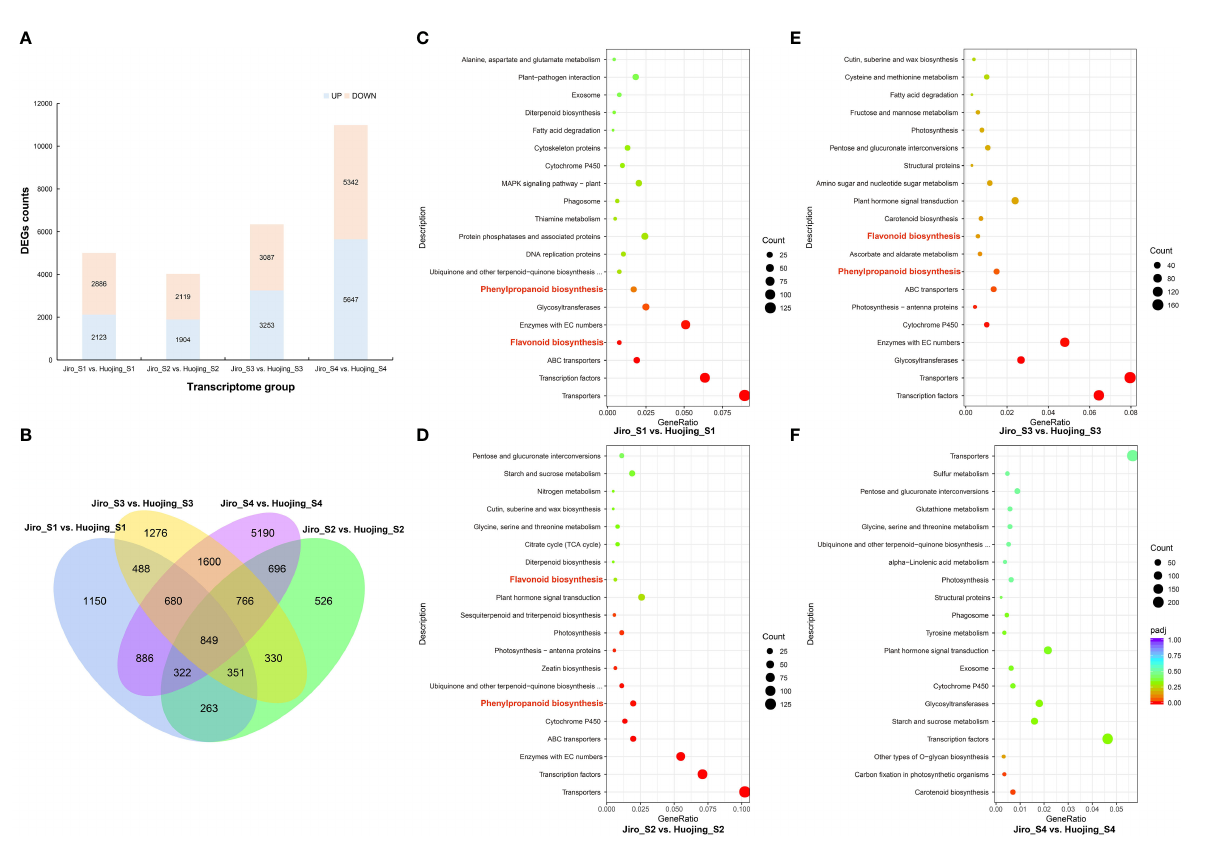
FIGURE 2 DEGs between ‘ Jiro ’ (PCNA type) and ‘ Huojing ’ (PCA type). (A) Summary of DEGs in different comparison groups of ‘ Jiro ’ and ‘ Huojing ’ fruit. (B) Venn diagram of DEGs. (c – f) Scatter plot showing KEGG enrichment of DEGs in four developmental stages in the ‘ Jiro ’ and ‘ Huojing ’ comparison groups. (C) Jiro_S1 vs. Huojing_S1 group. (D) Jiro_S2 vs. Huojing_S2 group. (E) Jiro_S3 vs. Huojing_S3 group. (F) Jiro_S4 vs. Huojing_S4